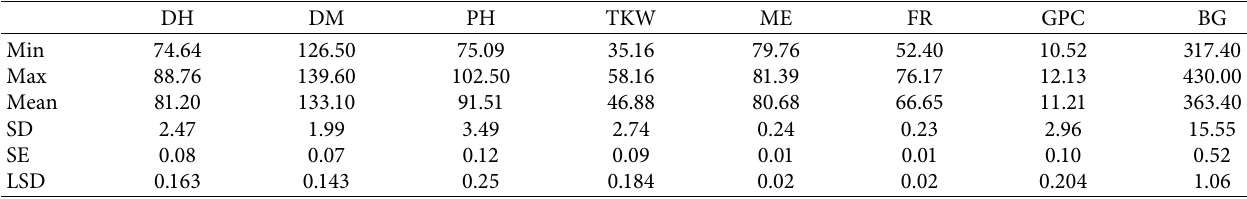
Table 5: Mean, minimum and maximum values estimated from 30 F4:5 RIL per cross based on 30 crosses tested across two environments. DH DM PH TKW ME FR GPC BG